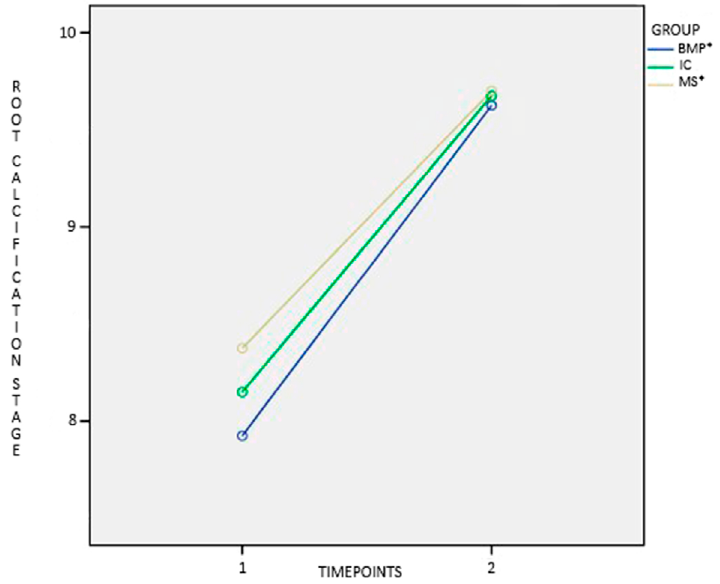
Figure 3- Interaction of time for PCCSs root calcification stage